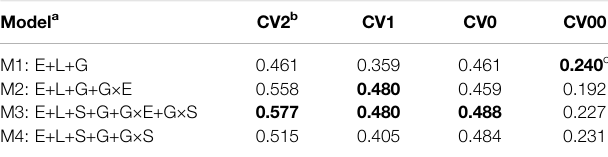
TABLE 2 | Weighted mean average correlation across environments for four cross-validation schemes and four